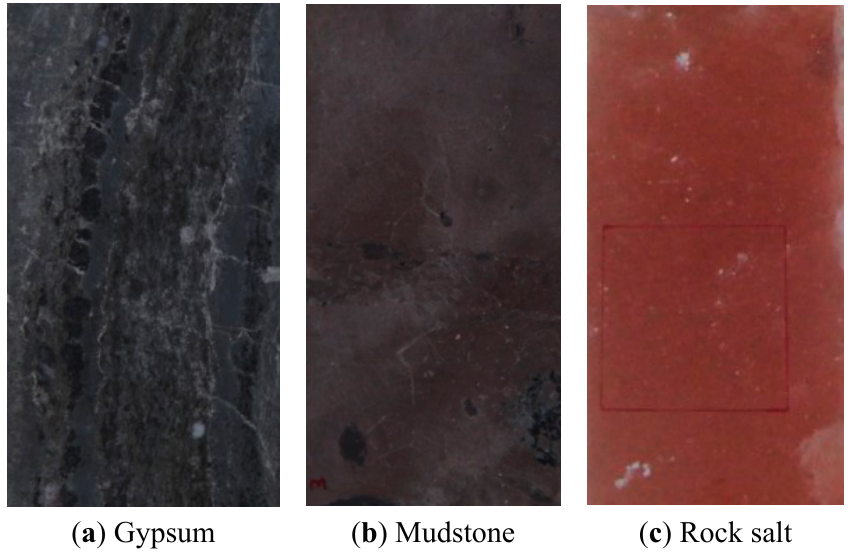
Figure 2. Specimens of gypsum, mudstone and rock